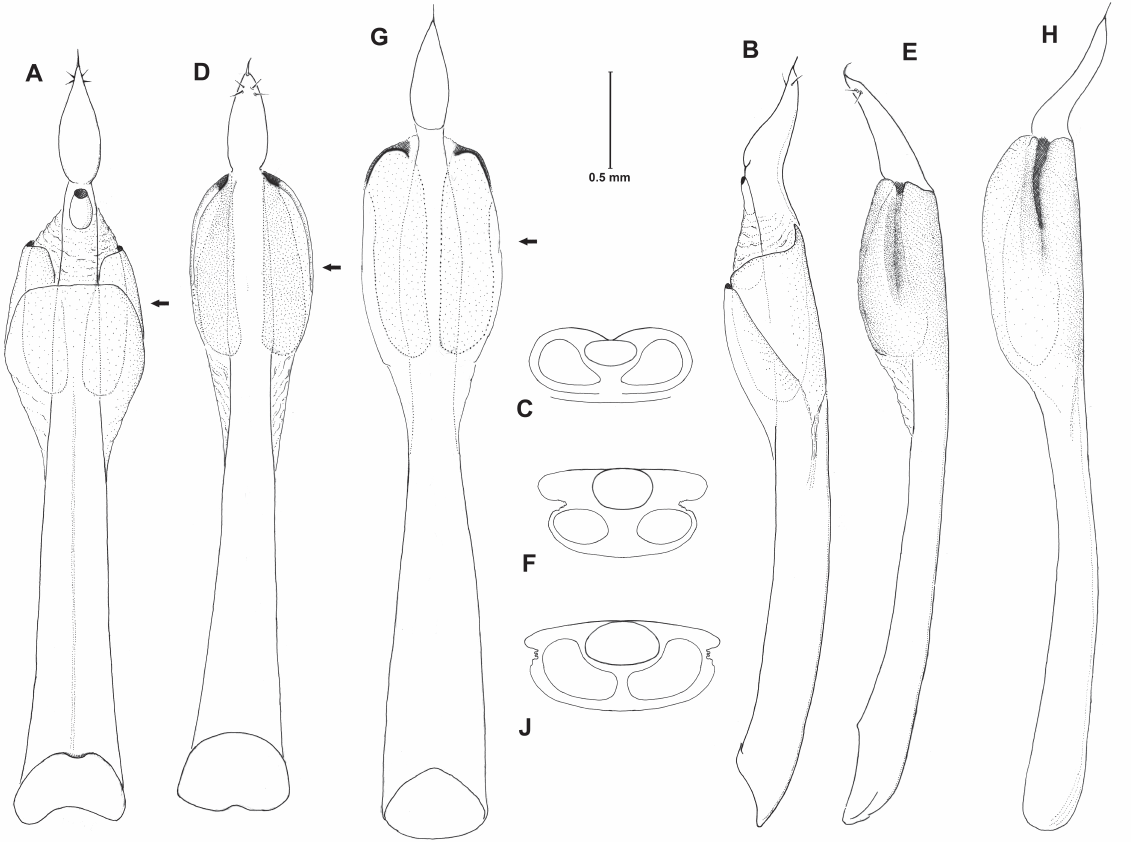
Fig. 5. Leiobunum , male genitalia. A–C . L. rupestre Herbst, 1799, Germany,